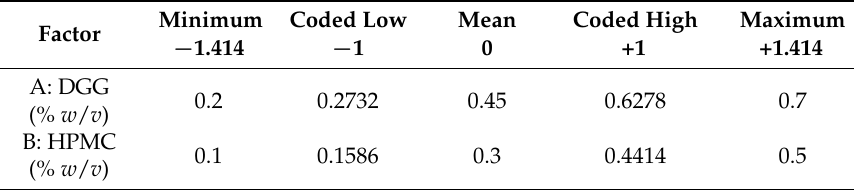
Table 1. Factor and levels in the optimization of in situ